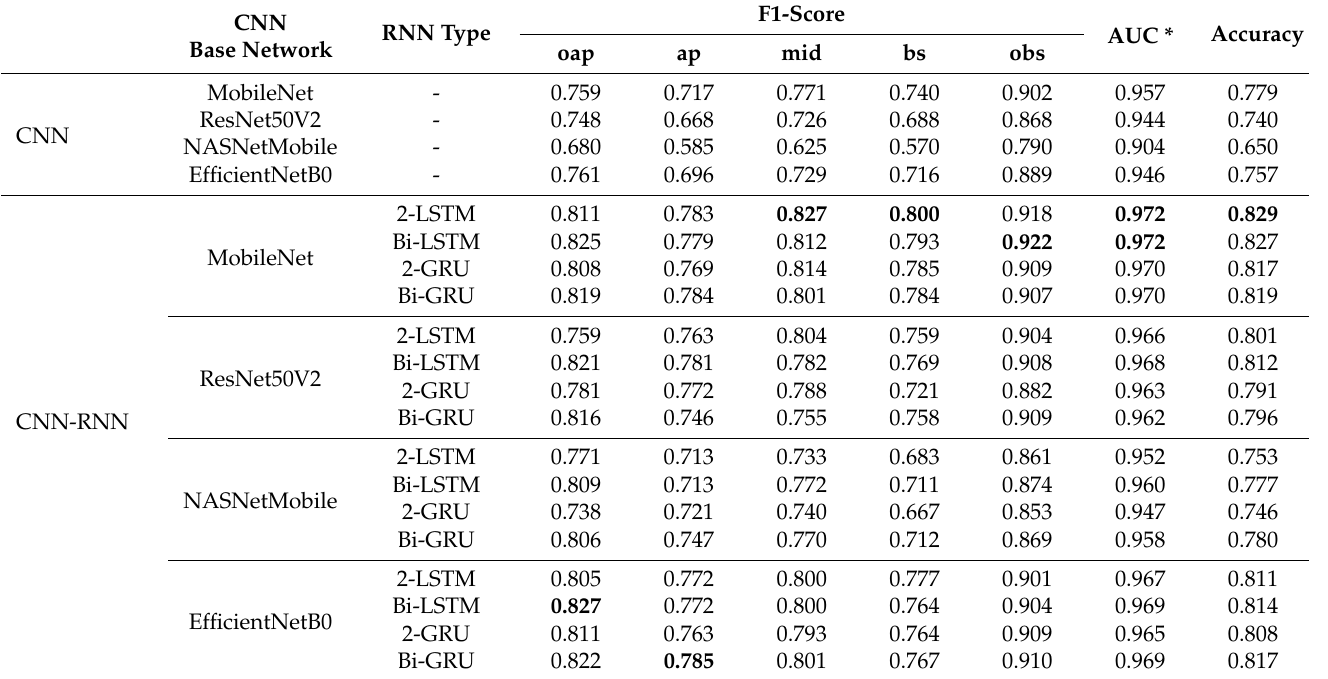
Table 5. Prediction performance of a variety of deep learning models. The bold indicates the highest value among the